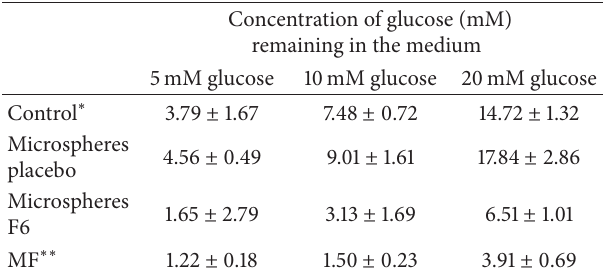
Table 4: In vitro glucose uptake by yeast cells incubated with micro- spheres placebo, microspheres F6, and metformin hydrochloride